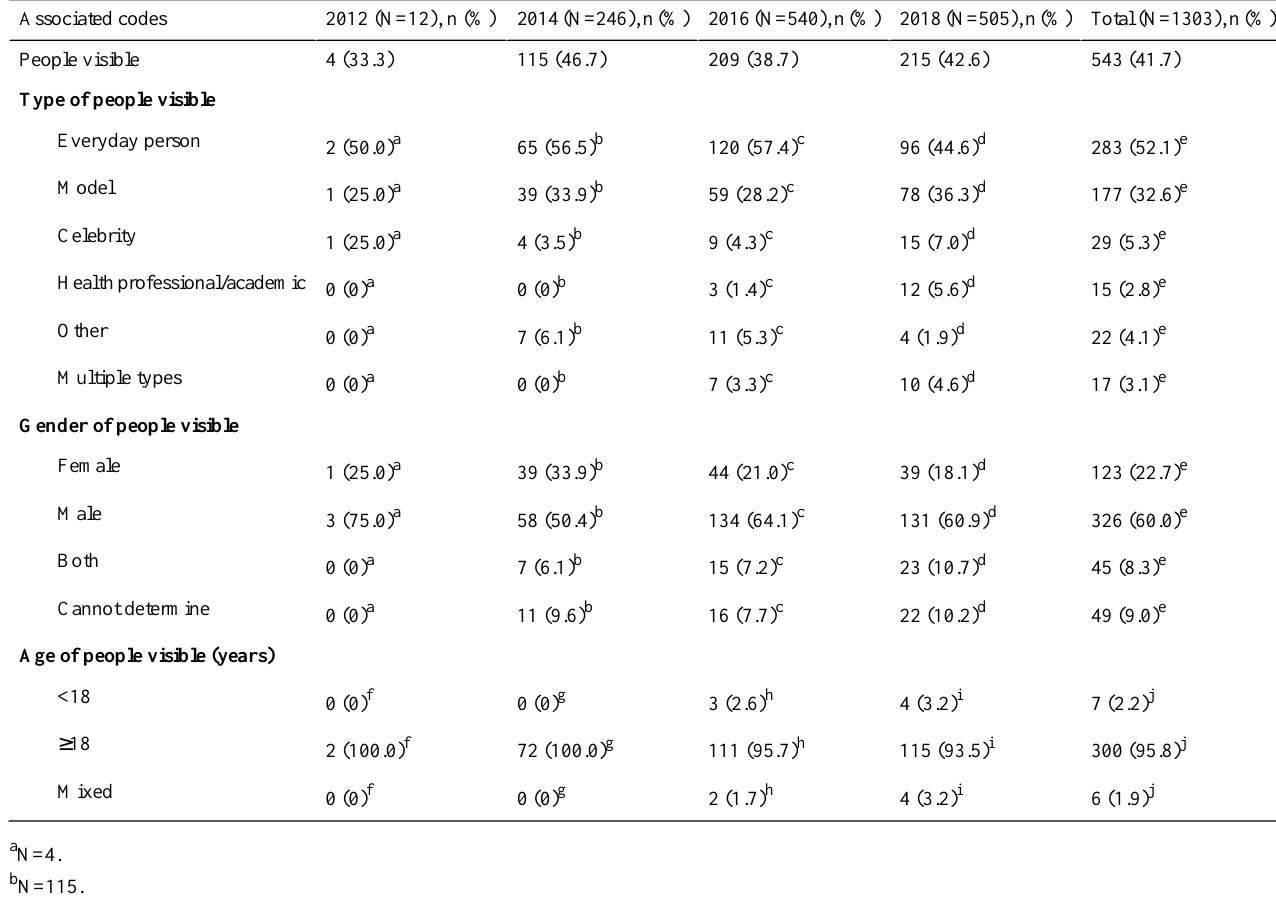
Table 2. Frequency statistics for each year corpus and the total sample within the “people”